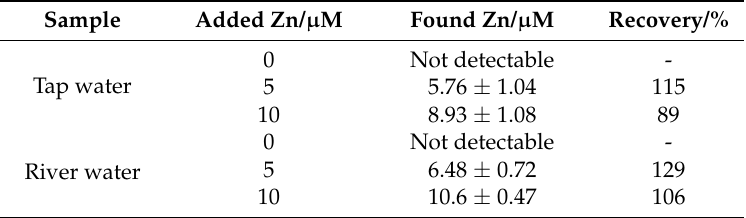
Figure 7. Comparison of Zn 2+ detection with the paper-based device developed in this study and a commercial Zn 2+ test strip. ( a ) Calibration curves for Zn 2+ in a background of 500 µ M Ca 2+ targeting real sample analysis recorded with the paper-based device developed in this study (red line) and a commercial Zn 2+ test strip (green line). ( b ) Scanned images of the Zn 2+ testing area of the developed device (top row) and a commercial test strip (bottom row) at the corresponding Zn 2+ concentrations in a background of 500 µ M Ca 2+ . Table 2. Quantification of Zn 2+ in spiked tap water and river water samples ( n = 3).